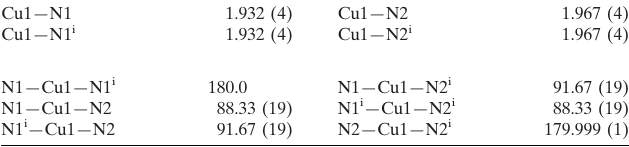
Selected geometric parameters (A˚ , (cid:4) ).